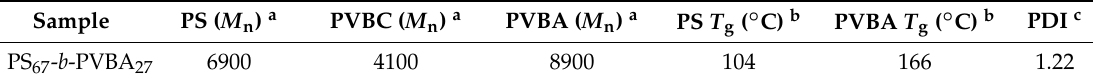
Table 1. Characteristics of the diblock copolymer PS- b -PVBA prepared in this study. Sample